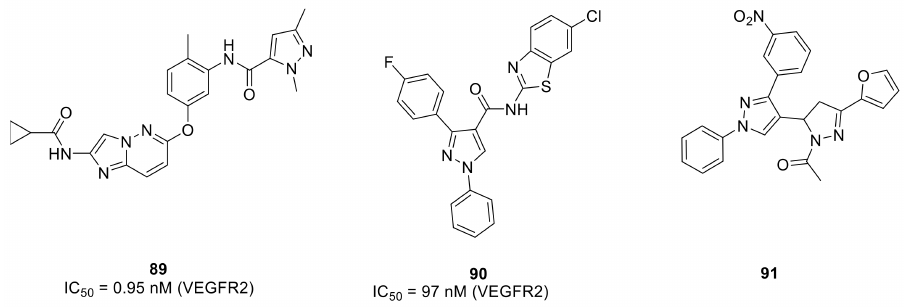
Figure 94. Structures of pyrazole-based VEGFR2 inhibitors and their IC 50